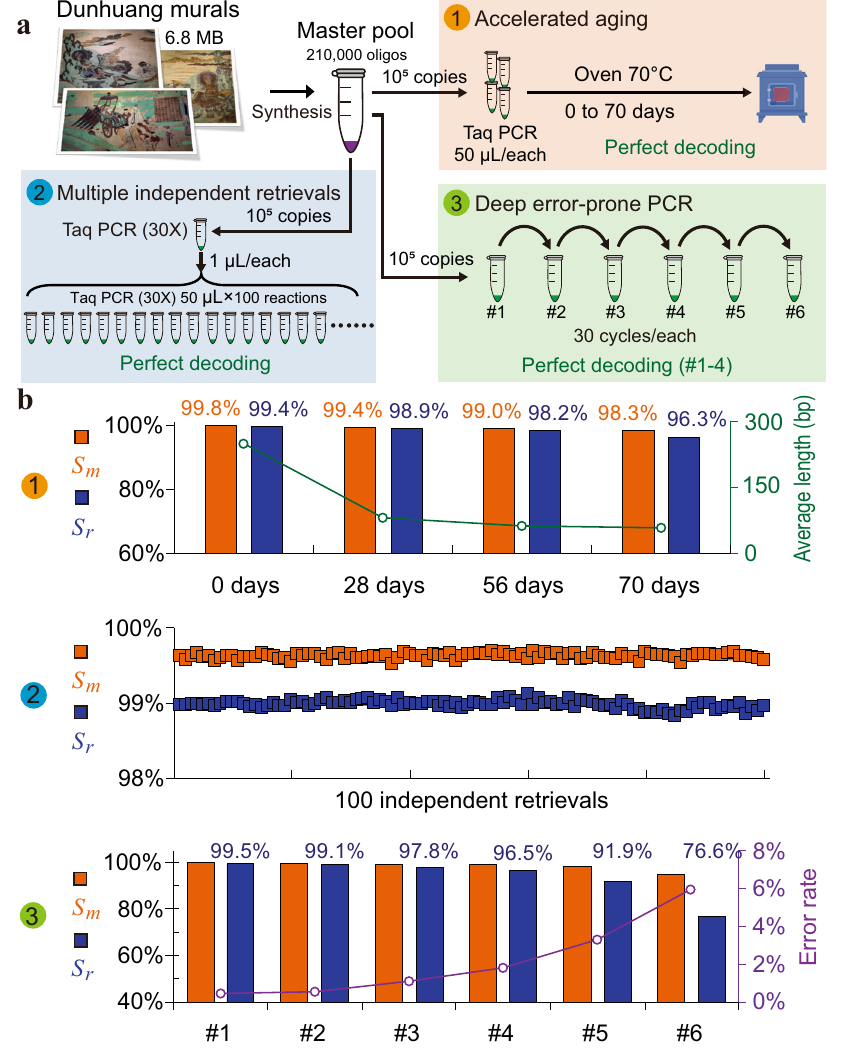
Fig. 3 | Experimental veri fi cation of the robustness of DBGPS. a Illustration of the three harsh experiments (1, 2, 3) performed to verify the robustness of DBGPS. A 6.8 MB zipped fi le of Dunhuang mural pictures was recorded by oligo synthesis, generating an ssDNA “ Master Pool ” with 210,000 unique types of ssDNA strands. Experiment 1, accelerated aging to verify the robustness with DNA degradations (breaks). Experiment 2, multiple data retrievals with intended unspeci fi c ampli fi cations to verify the robustness with strand rear- rangements. Experiment 3, deep error-prone PCR to introduce errors. b Data